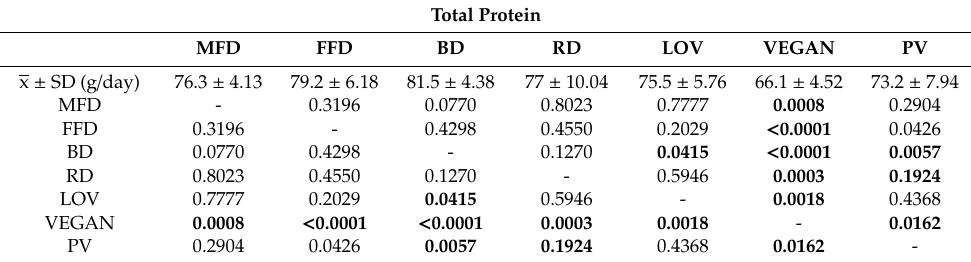
Table 2. The average content of proteins between the diets (g /